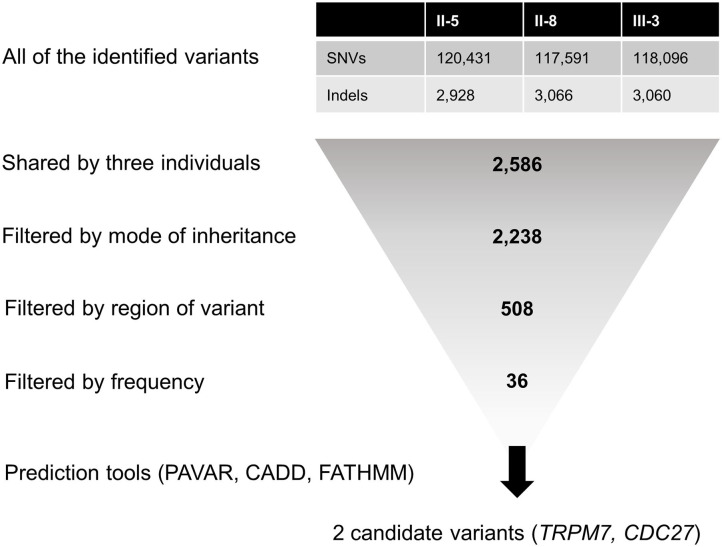
Filtering steps applied to the whole-exome sequencing data. CADD, Combined Annotation-Dependent Depletion; FATHMM, Functional Analysis Through Hidden Markov Models; Indels, insertions/deletions; PAVAR, pathogenic variants risk composite score; SNVs, single-nucleotide variants.